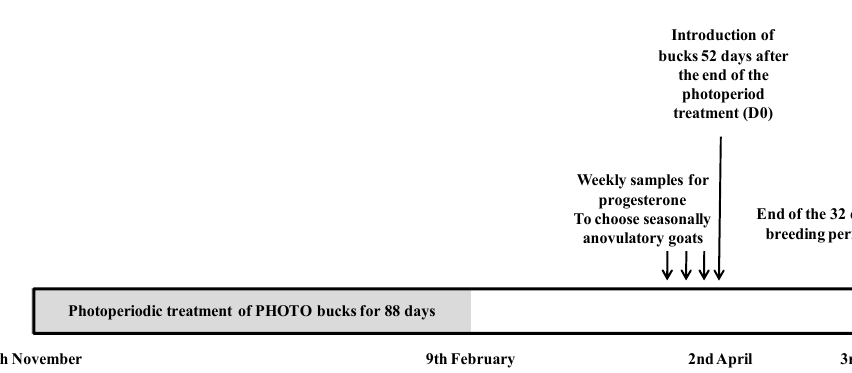
Figure 1. Experimental design of the male effect using bucks of Murciano–Granadina breed or Blanca Andaluza breed subjected to the photoperiodic treatment, i.e., long days for three months between November and February or not.